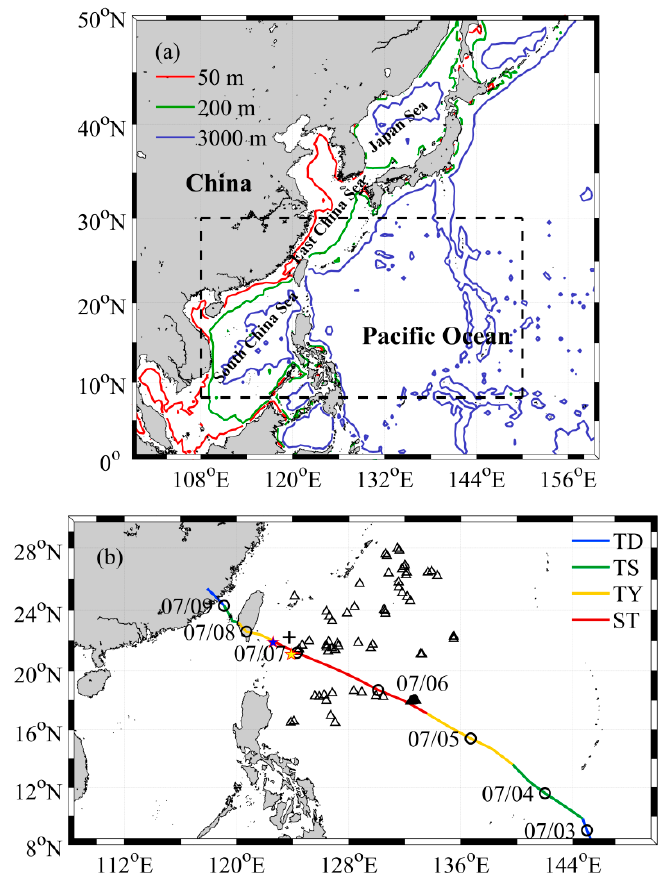
Figure 1. (a) : Model computational domain and bathymetry. The red, green, and purple lines show the 50 m, 200 m, and 3000 m isobaths, respectively. The black dashed box indicates the enlarged region. (b) : The best track of TC Nepartak. The colors indicate the stage of TC development. TD: tropical depression; TS: tropical storm; TY: typhoon; ST: super typhoon. Cross represents the Argo float 2902666. Another 69 recording positions are marked with triangles. The yellow and blue pentacle stars show the location of the NTU1 and NTU2 buoys, respectively.